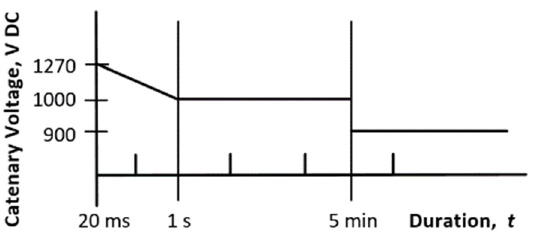
Figure A1. Permissible voltage variations in 750 V DC catenary line.